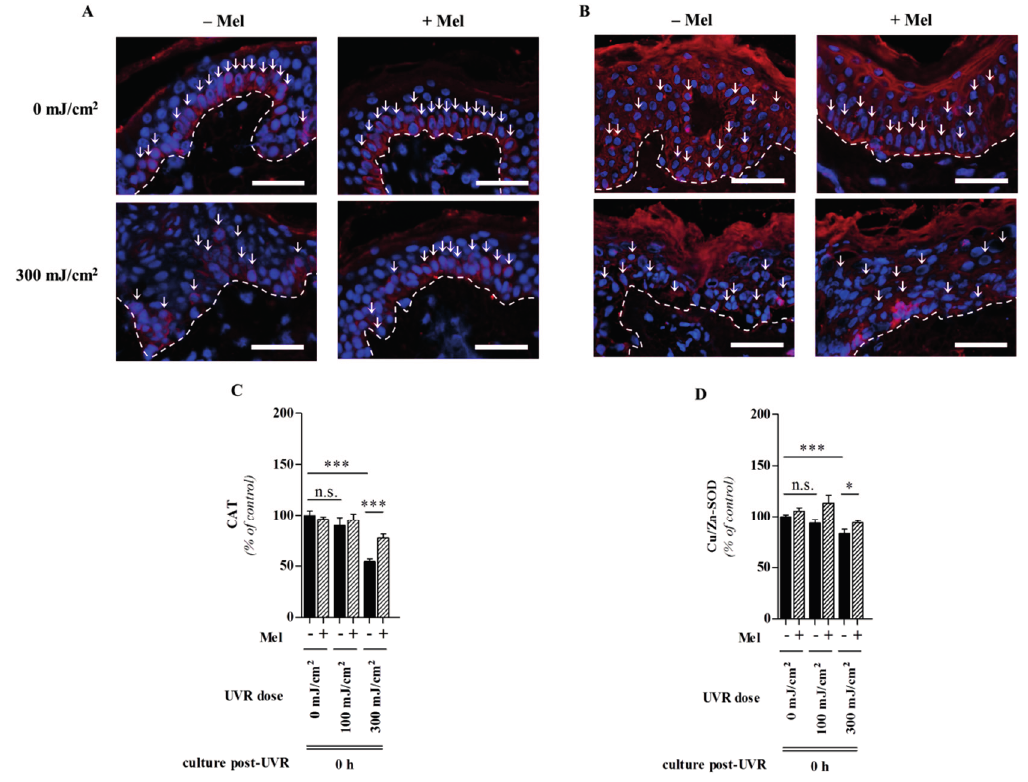
Figure 8. Protective effect of melatonin against UVR-mediated decrease of anti-oxidative enzymes in human skin in dose-dependent manner. UVR-induced decrease of CAT ( A ) or Cu/Zn-SOD ( B ) in situ protein expression was noticed directly post-UVR at the dose of 300 mJ/cm 2 and melatonin induced enhanced antioxidant enzyme expression. Enzymes were detected using antibodies conjugated with rhodamine (red), DAPI was used for the nucleus (blue). One representative experiment of three is shown. Dashed line shows the basement membrane. Arrows show CAT and Cu/Zn-SOD positive cells. Bars = 50 μ m (magnification, 500×). Evaluated data, ( C , D ), were presented as pooled means ± SEM of three independent experiments containing six images taken per condition. Values were expressed as percentage of the control value, i.e. , sham-irradiated without melatonin at 0 h post-UVR. Statistically significant differences were indicated as * p < 0.05; *** p < 0.001; n.s., not significant, using the ANOVA with appropriate post hoc testing (modified after Fischer et al. [144] with permission from the